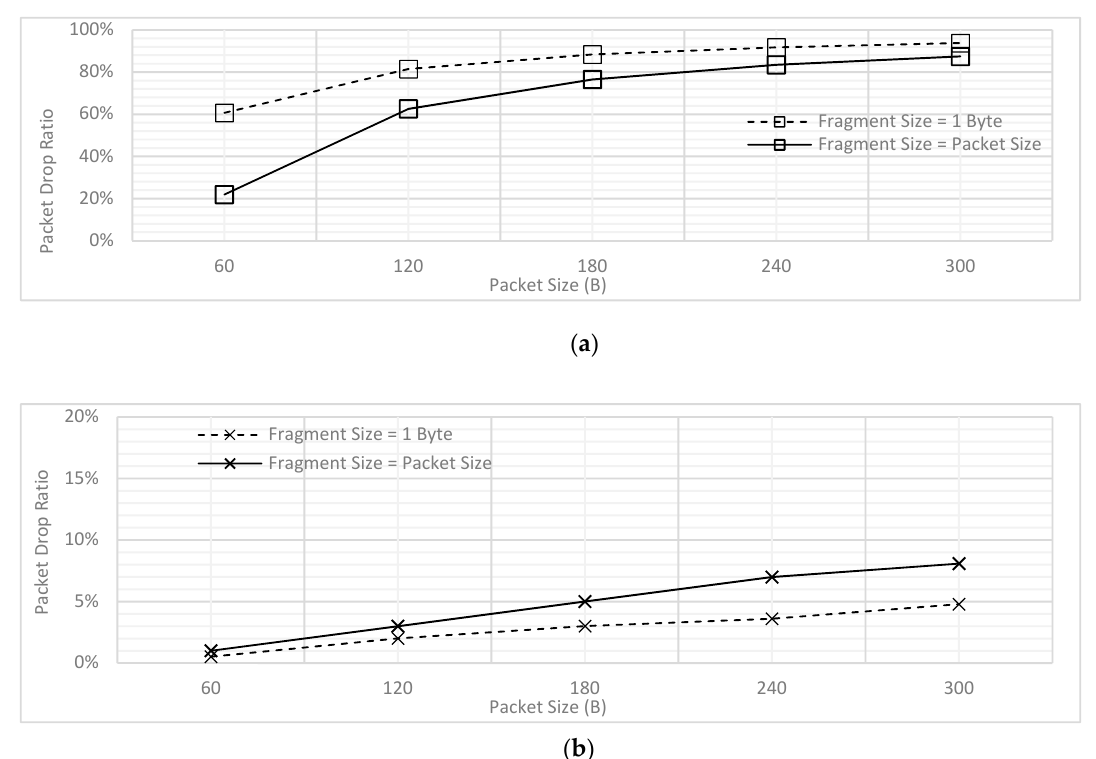
Figure 13. Comparing the Influence of Fragmentation on PDR ( a ) Low Priority Traffic ( b ) High Priority Traffic.